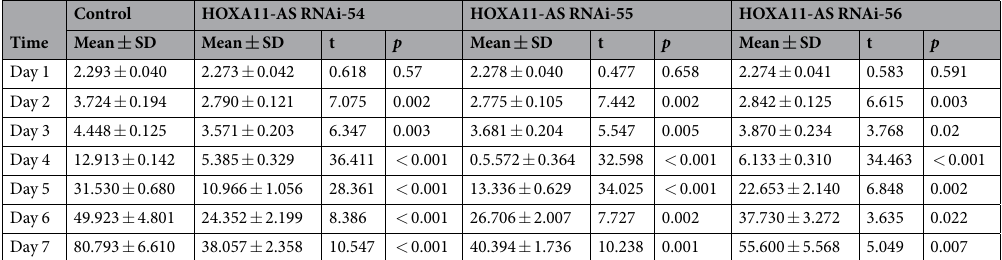
Table 1. Effect of HOXA11-AS RNAi on proliferation of the NSCLC A549 cell line, determined by cytometry assays. t values were obtained by comparison with the negative control.